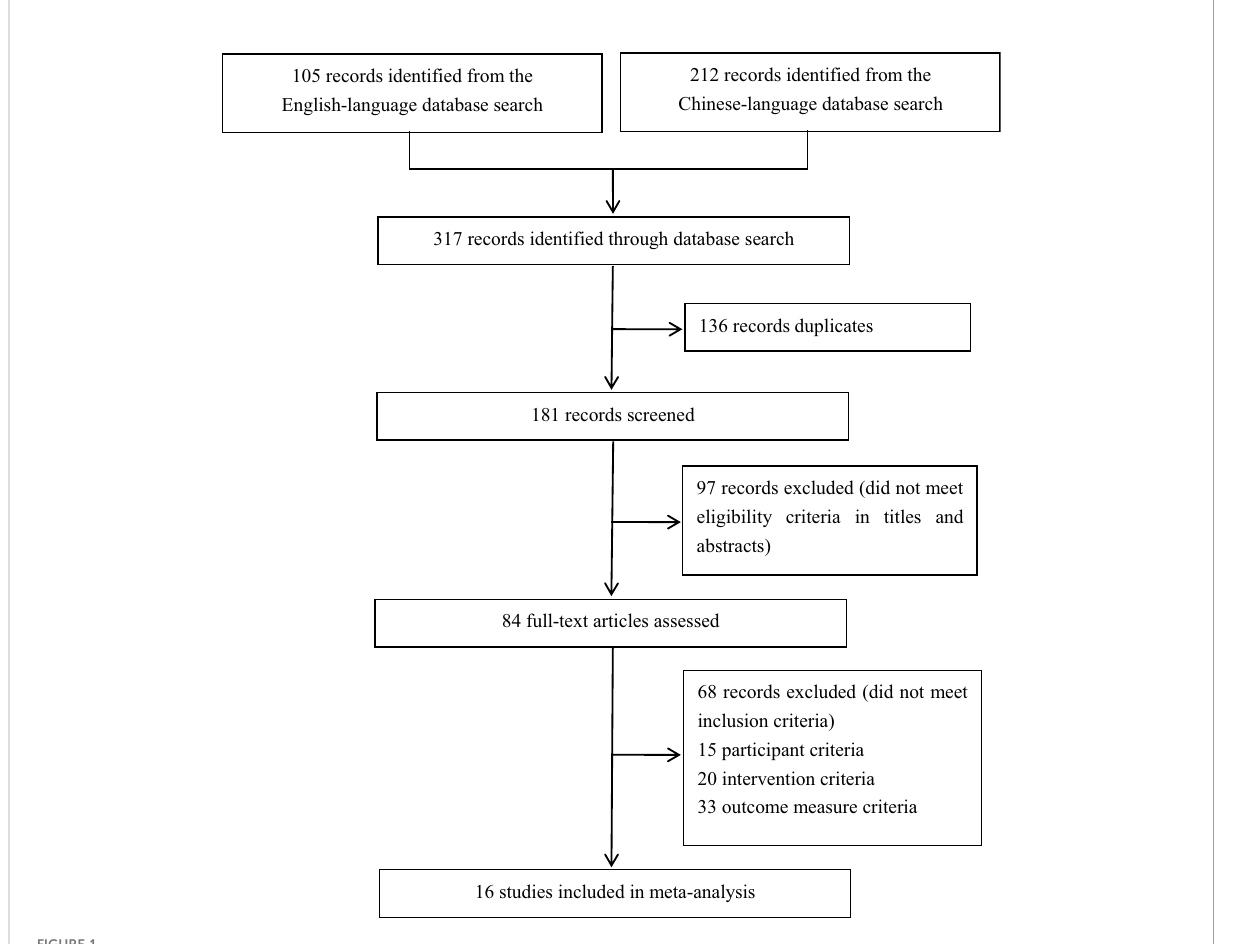
FIGURE 1 Flow diagram of literature search and study